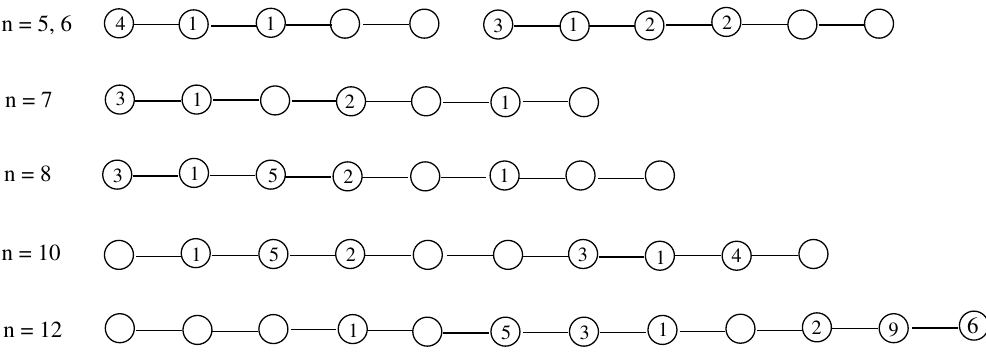
Figure 8: Antiregular dominating labelings of P